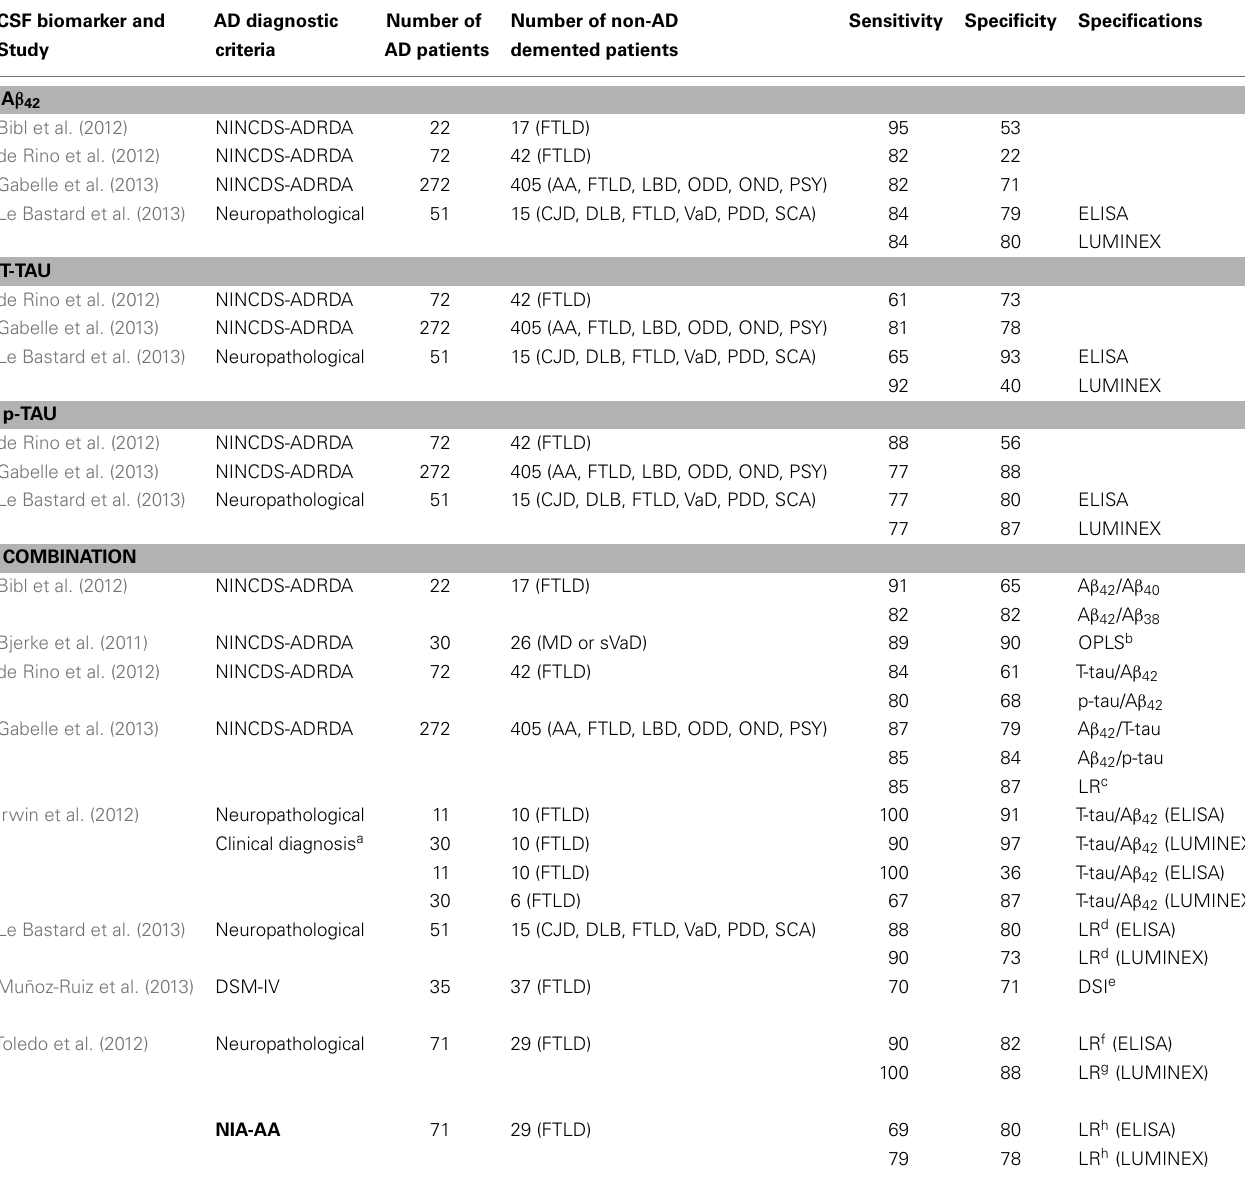
Table 7 | Primary studies published after the new revised diagnostic criteria (AD vs. other dementias): sensitivity and specificity